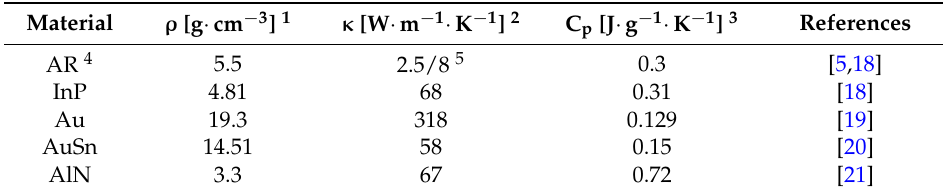
Table 1. Physical parameters used for FEM